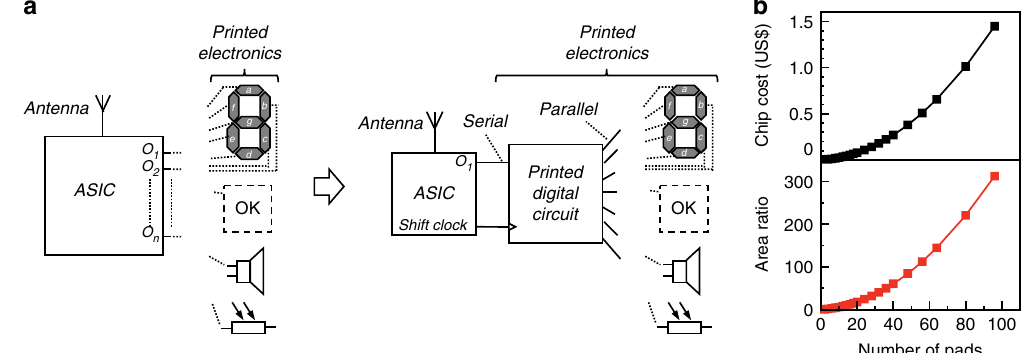
Fig. 1 Concept of hybrid electronics systems combining printed electronics and silicon chips. a Application-speci fi c integrated circuits (ASIC) require a large number of pads to implement multiple functionalities. Printed digital circuits can signi fi cantly reduce the number of pads, hence, the twinning of printed electronics and Si-based electronics into hybrid electronics systems enable ultra-low-cost applications. b The non-linear growths of ASIC chip processing cost and required chip area as the number of pads increases; the cost and area estimations are based on an 8-inch silicon wafer at a processing cost of 1500 US$, a pad area of 0.01 mm 2 and a pad pitch of 0.15